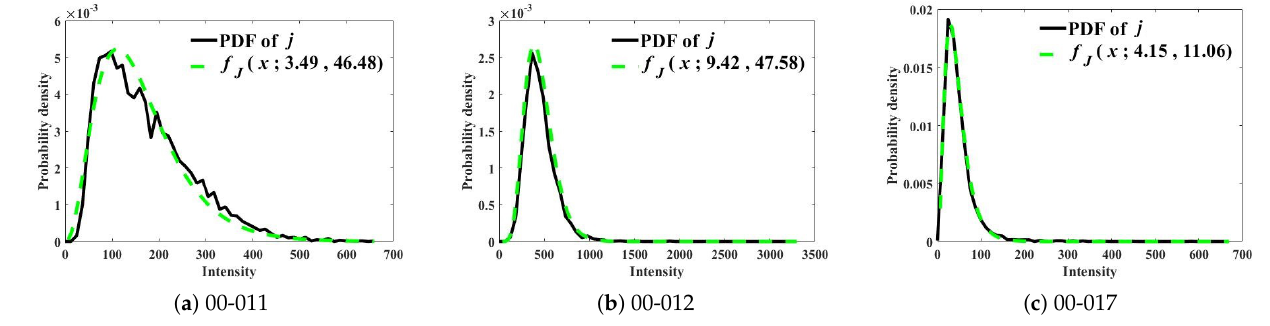
Figure 5. Comparison of the PDF of j with f J ( x ; α m , α d